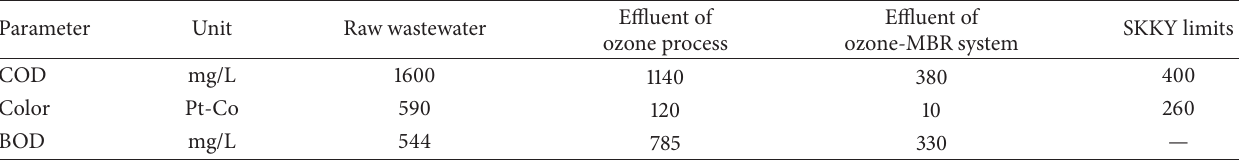
Table 2: Textile wastewater characteristics and discharge limits according to SKKY (wool scouring, finishing, weaving, and equivalents). Parameter